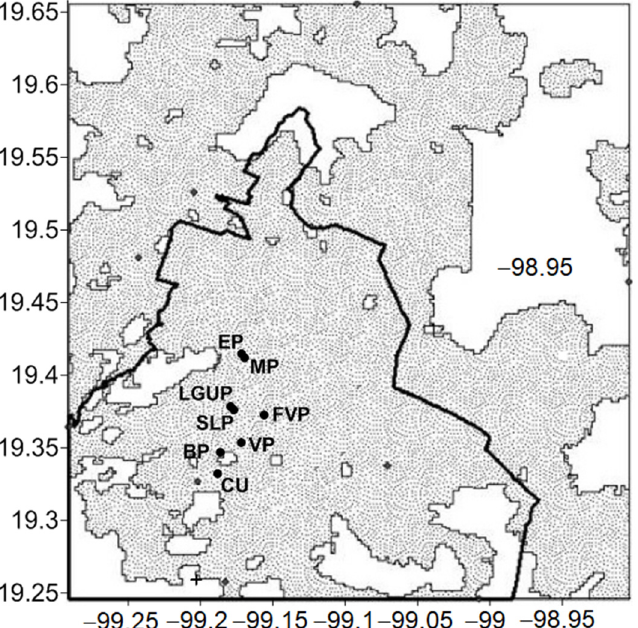
Figure 1. Location of the sites where measurements were collected in the Metropolitan Area of Mex- ico City (MAMC). The shaded area represents the MAMC and the solid line locates the boundary between Mexico City and the urban area in the State of Mexico. Abbreviation corresponds to